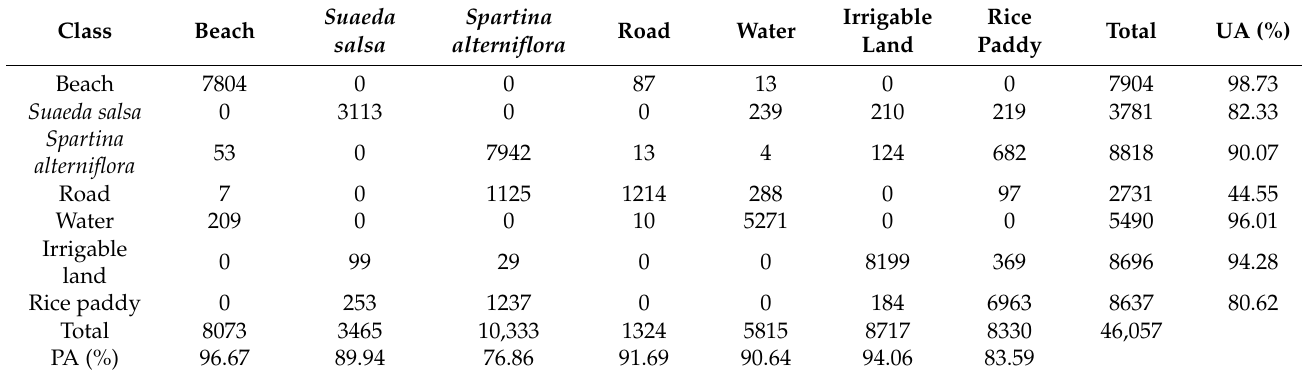
Table 7. Confusion matrix of the classification results from the Y4 features set.